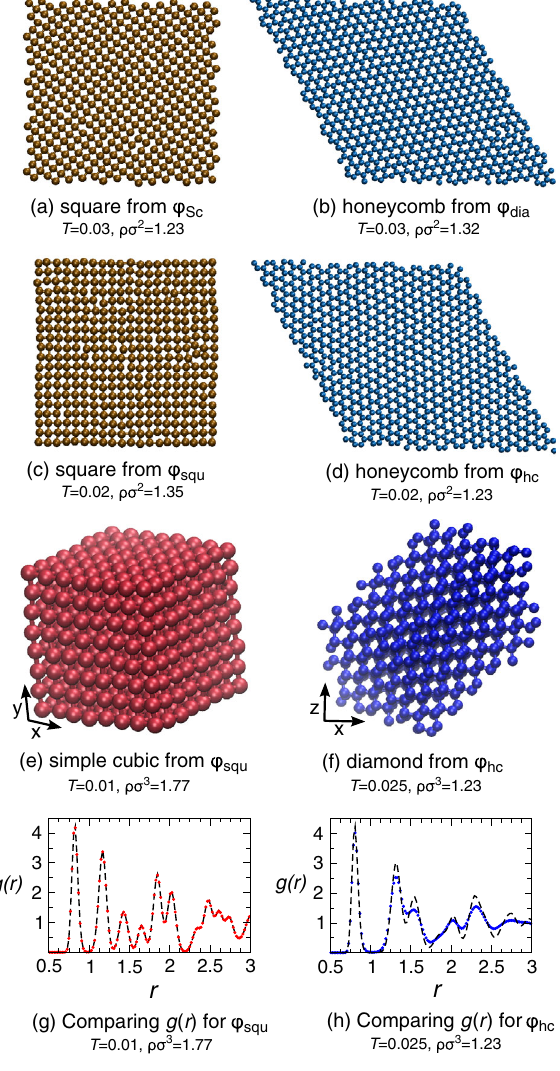
FIG. 4. Snapshots of 2D configurations obtained from Monte Carlo quenches of (a) φ , (b) φ , (c) φ , (d) φ Sc dia squ hc and 3D configurations obtained from quenches of (e) φ and squ (f) φ . For the 3D structures, we plot the corresponding pair hc distribution functions g ð r Þ of the quenched configurations (dots) and the perfectly equilibrated lattice structures (dashed lines) in (g) and (h), at the specific temperature ( T ) and density ( ρ ), to demonstrate the structural similarities. The comparison between the pair distribution functions of the annealed and perfectly equilibrated diamond lattice in (h) shows that the annealed structure is not quite defect free, but the configuration energy is only 0.09% higher than that of the perfect lattice. For more details, see Table S1 in the Supplemental Material